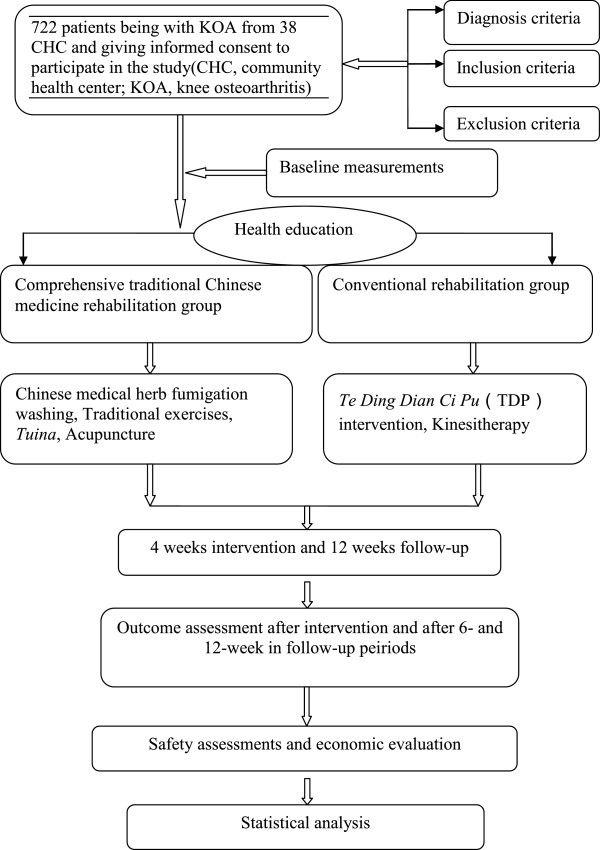
Study flow chart.